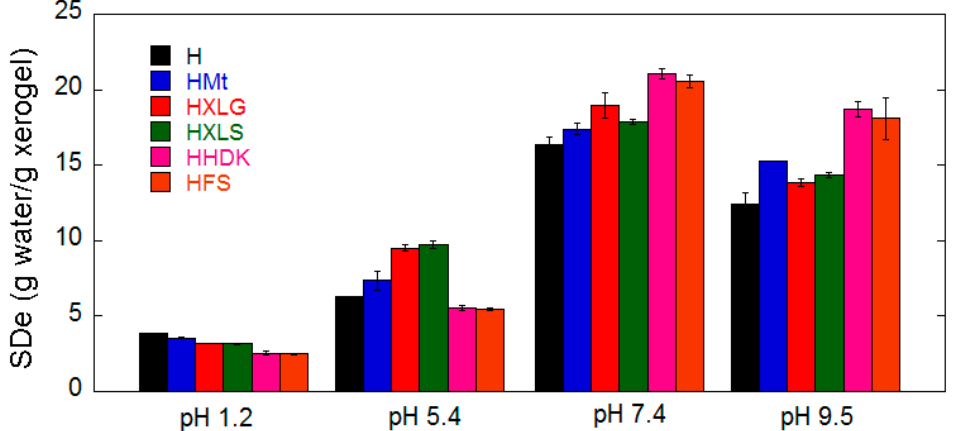
Figure 5. Equilibrium swelling degree in four different pH media.